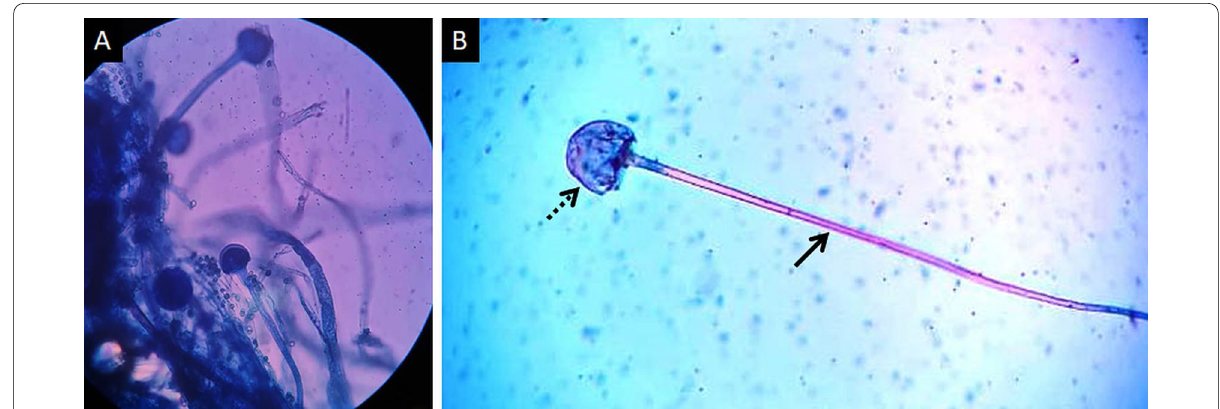
Fig. 1 Lactophenol cotton blue (LCB) stained tissue mount ( a ) performed for the demonstration of sporangiophores, the early stage in the life cycle of MCR. High-power photomicrograph ( b ) of a single sporangiophore (thick arrow) with a bulbous, sac-like sporangium (dotted arrow) containing new fungal spores